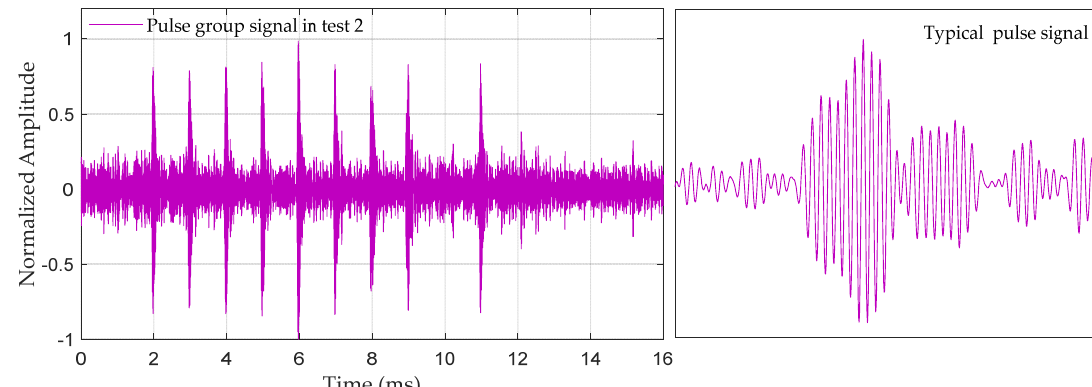
Figure 13. eLoran signal collected in Test 2.